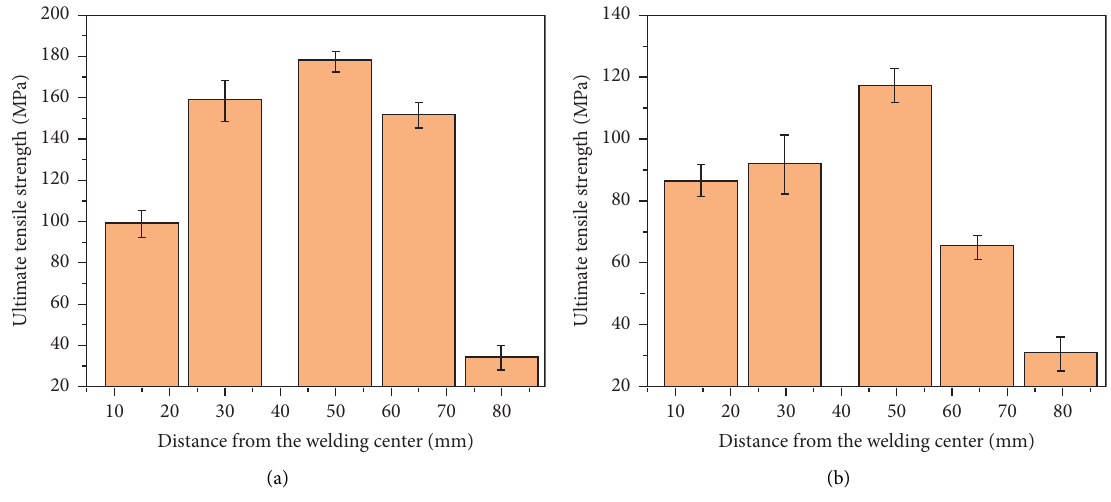
Figure 18: Tensile properties of all T-joints: (a) pulled along the skin and (b) pulled along the